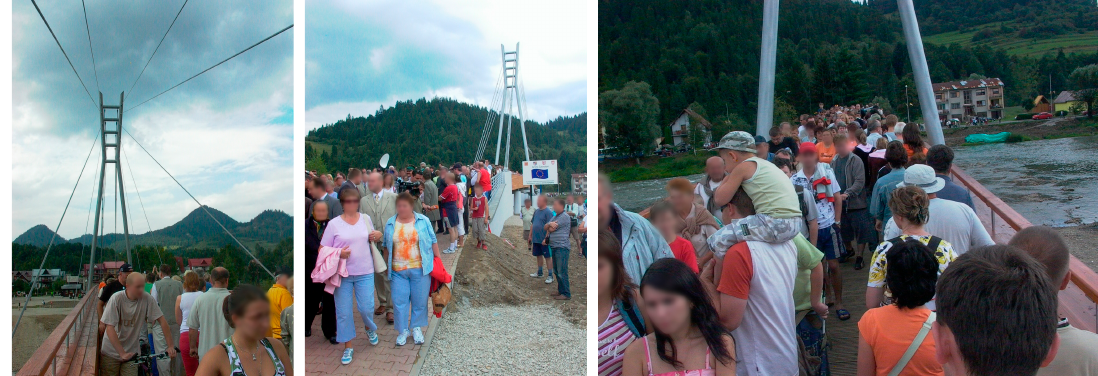
Figure 31. Very dense pedestrian traffic on the cable ‐ stayed footbridge during the Opening Cere ‐ mony.